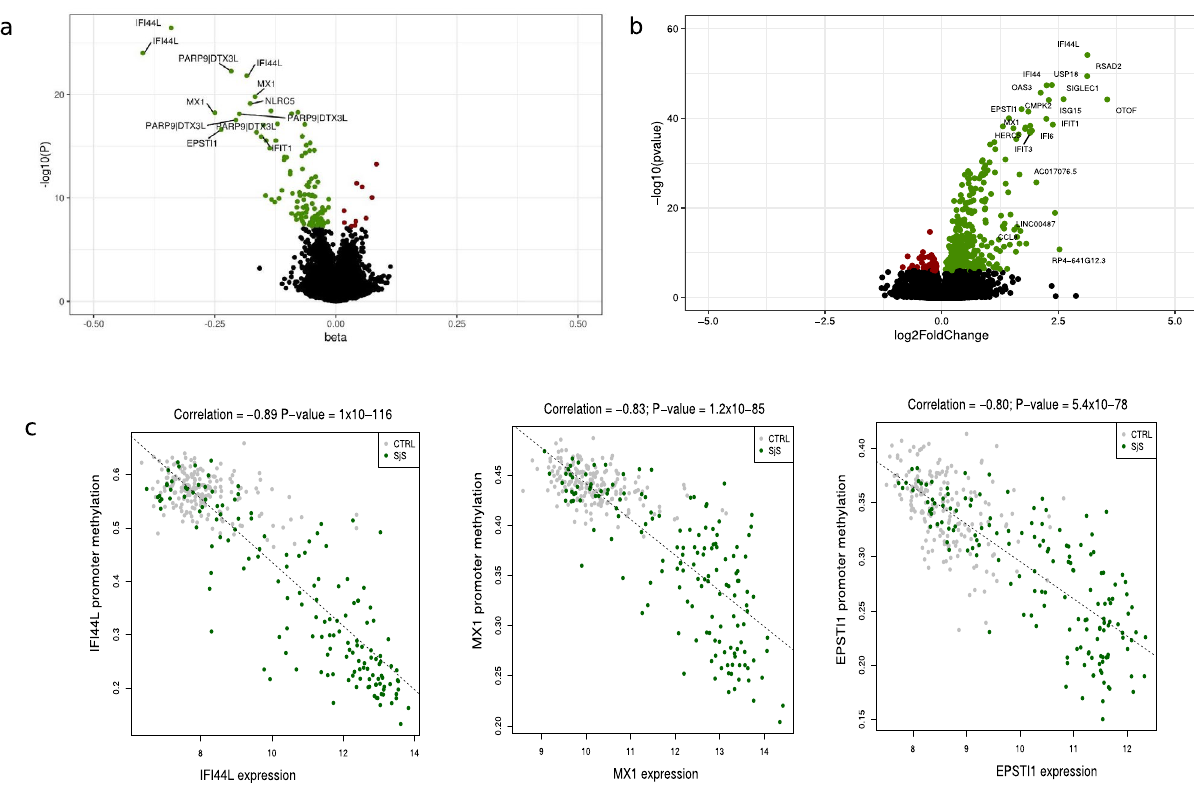
Figure 1. DNA methylation and gene expression patterns associated with SS. Volcano plot for the differential DNA methylation association study in the discovery cohort. P -values are represented on the –log10 scale in the y-axis. The effect size and direction obtained for each CpG site is depicted in the x-axis. Green dots represent significant associations with negative sign (hypomethylation). Red dots represent significant associations with positive signs. The top associations are labeled with gene names. ( b ) Volcano plot for the differential expression analysis in the discovery cohort. The effect size and direction obtained for each gene is depicted in the x-axis. Green dots represent significant associations with positive sign (overexpression). Red dots represent significant associations with negative signs. The top associations are labeled with gene names. ( c ) Plots showing high correlation between an average of DNA methylation quantified as β-values at the promoters of the most significant SS-associated DMRs and gene expression at the logarithmic scale. R software 73 and Adobe Illustrator (https:// www. adobe. com/) was used to create